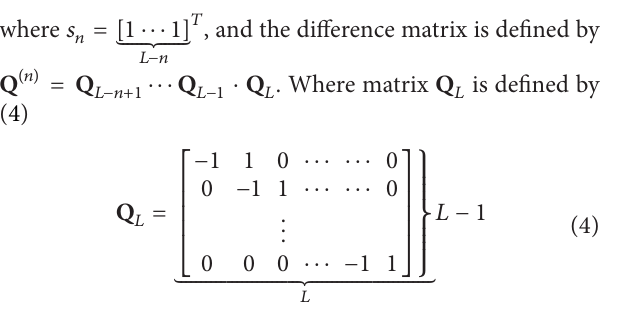
Figure 3: New detector scheme.